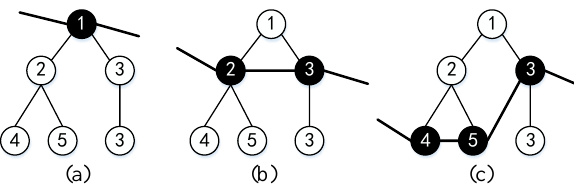
Figure 4. All valid tree slices of a particular BPT. Each slice is highlighted a black curve, the nodes on the slice are darkened.